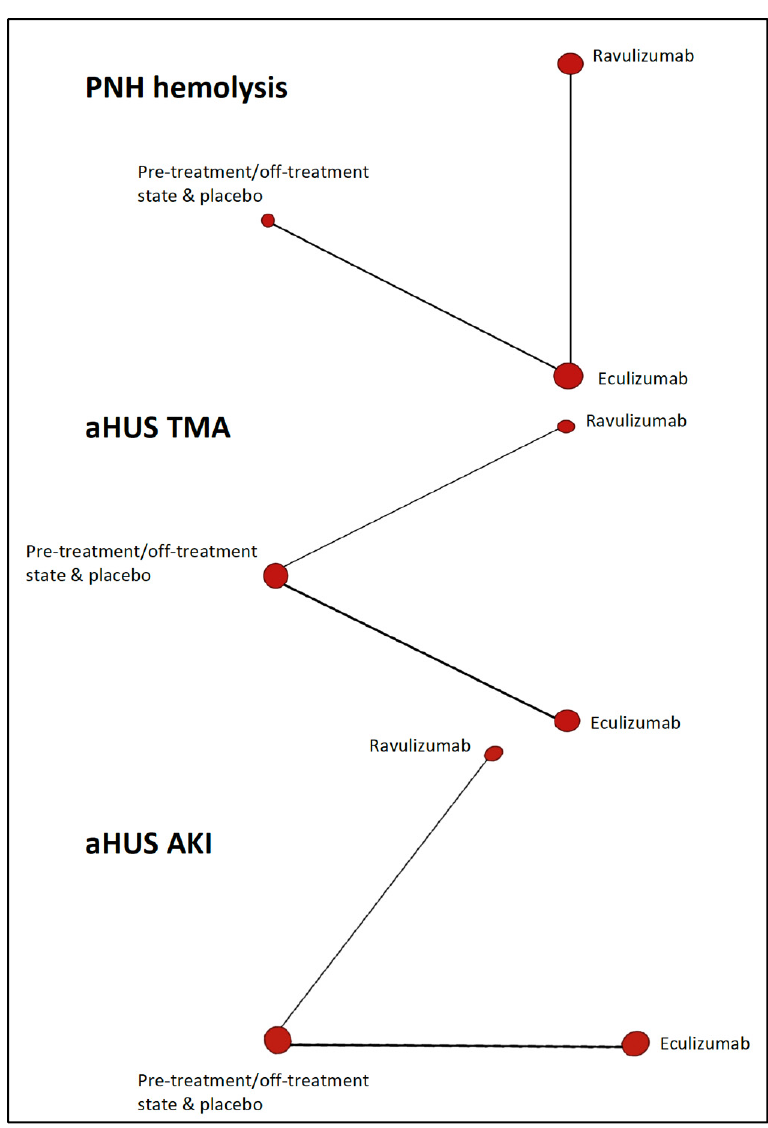
Figure 2. Bayesian network diagrams for the competing complement C5 inhibitors corresponding to three outcomes (clinical trials). aHUS, atypical hemolytic uremic syndrome; AKI, acute kidney injury; PNH, paroxysmal nocturnal hemoglobinuria; TMA, thrombotic microangiopathy.